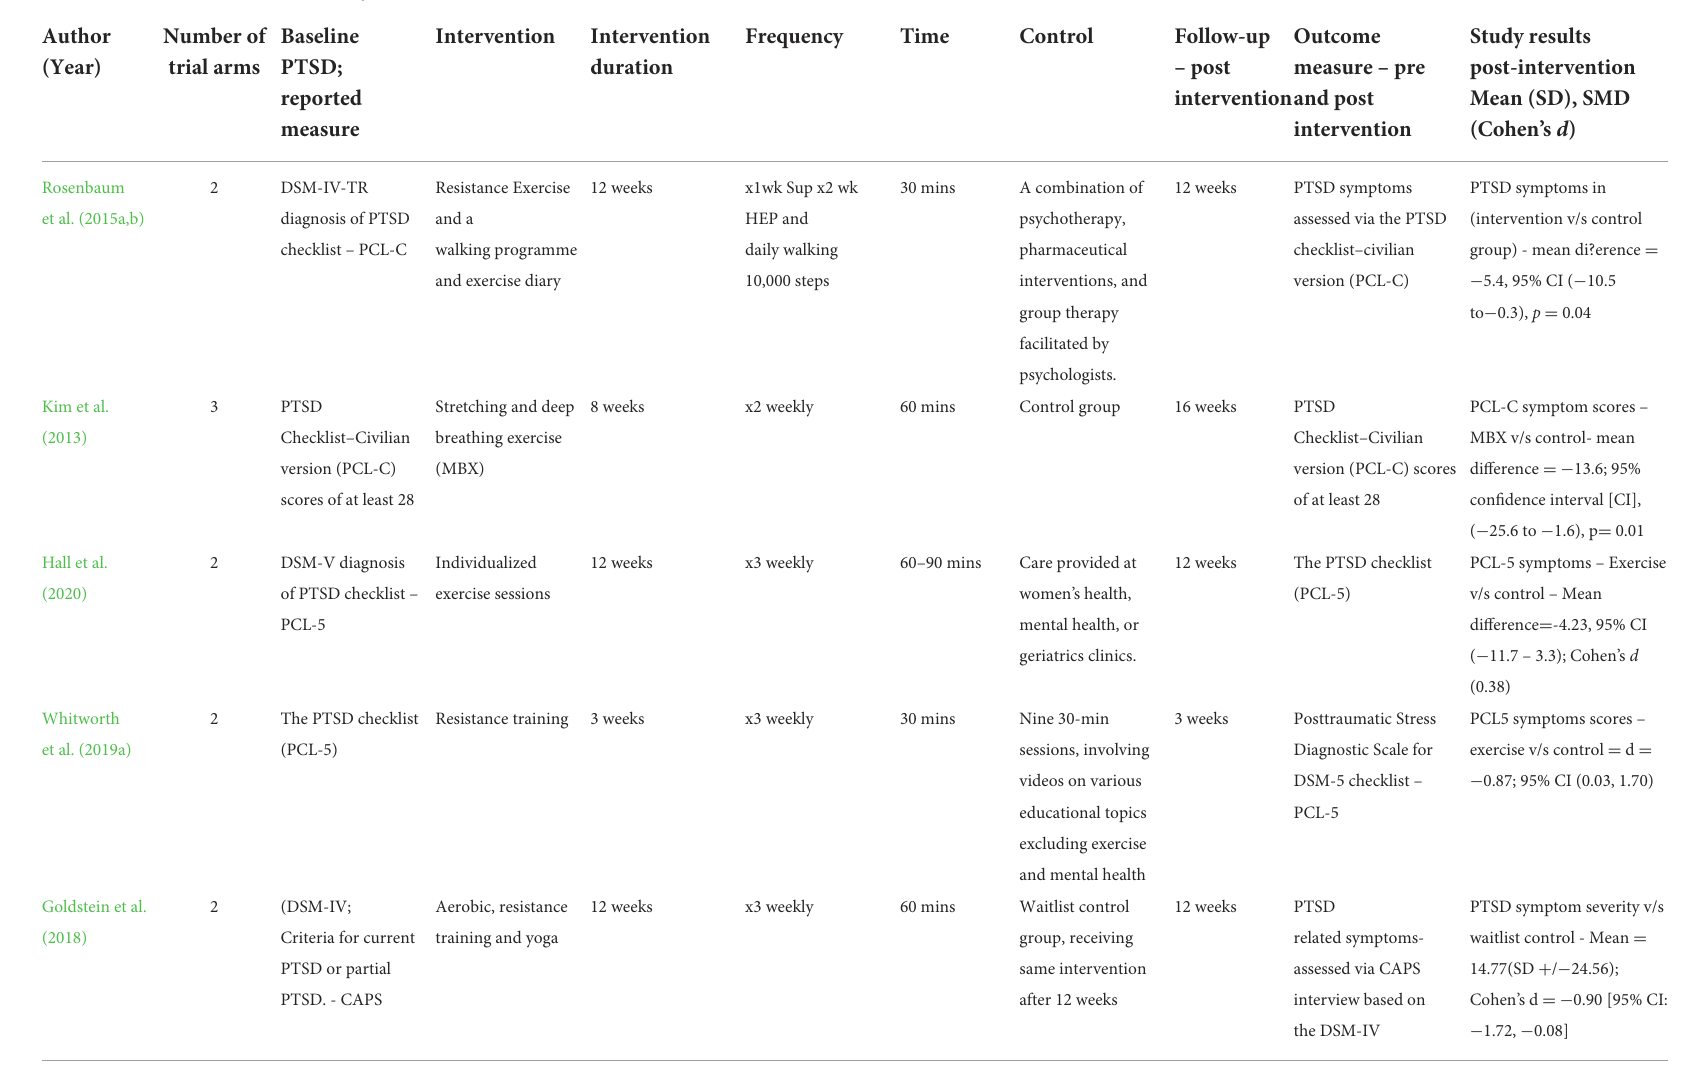
TABLE 5 Intervention and control component